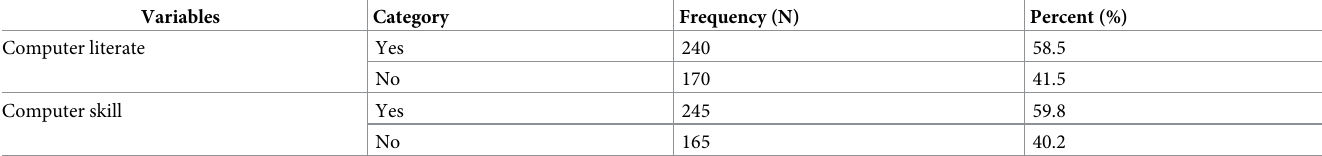
Table 2. Technical factors towards telemedicine readiness among health professionals at private hospitals in the Amhara region 2021.